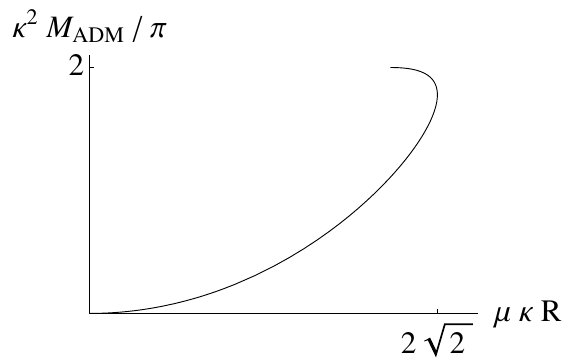
Figure 2 . Asymptotic mass-radius curve for the BPS baby Skyrmions with the old baby potential in the asymptotically (cid:13)at U (cid:25)